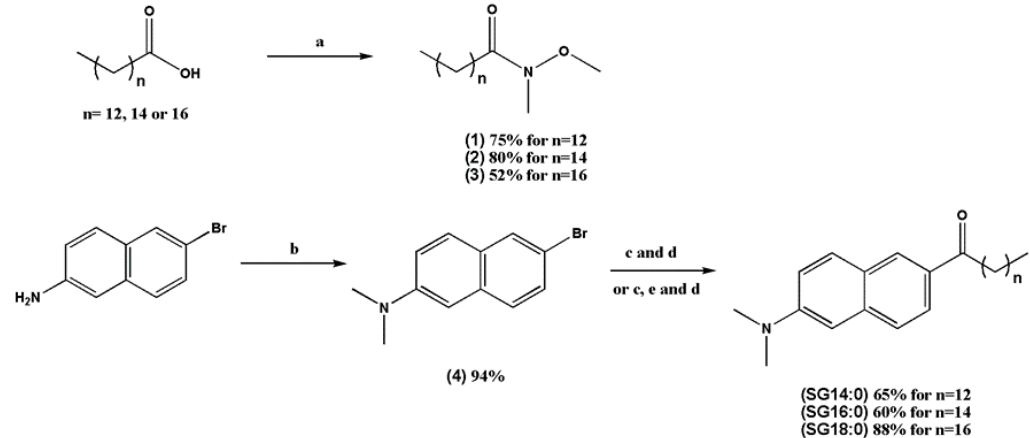
Figure 1. Synthesis of SG14:0, SG16:0, and SG18:0. Reagents and conditions: ( a ) N, O-dimethylhydroxylamine hydrochloride, EDC-HCl, DMAP in CH 2 Cl 2 , rt, 12 h. ( b ) 3 M H 2 SO 4 , 40% aqueous formaldehyde, NaBH 4 , THF, pH = 6, from 0 °C to rt, 2 h. ( c ) n -Buli, THF, −78 °C, 1 h, from −78 to 0 °C, 2 h. ( d ) Weinreb amide 1 – 3 , THF, 0 °C 12 h. ( e ) MgBr 2 etherate, THF, −78–0 °C, 2 h.